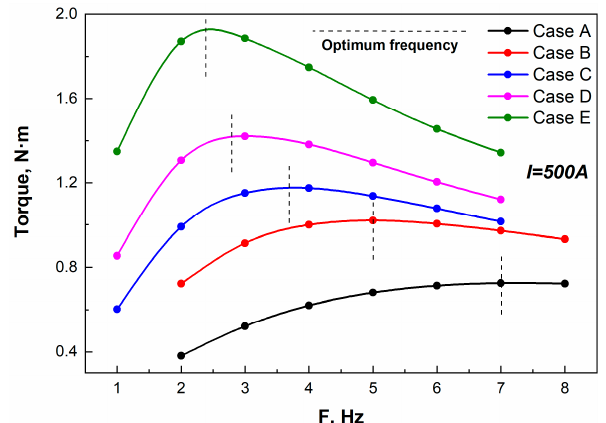
Figure 11. Relationship between the electromagnetic torque of strand and the current frequency under different schemes.